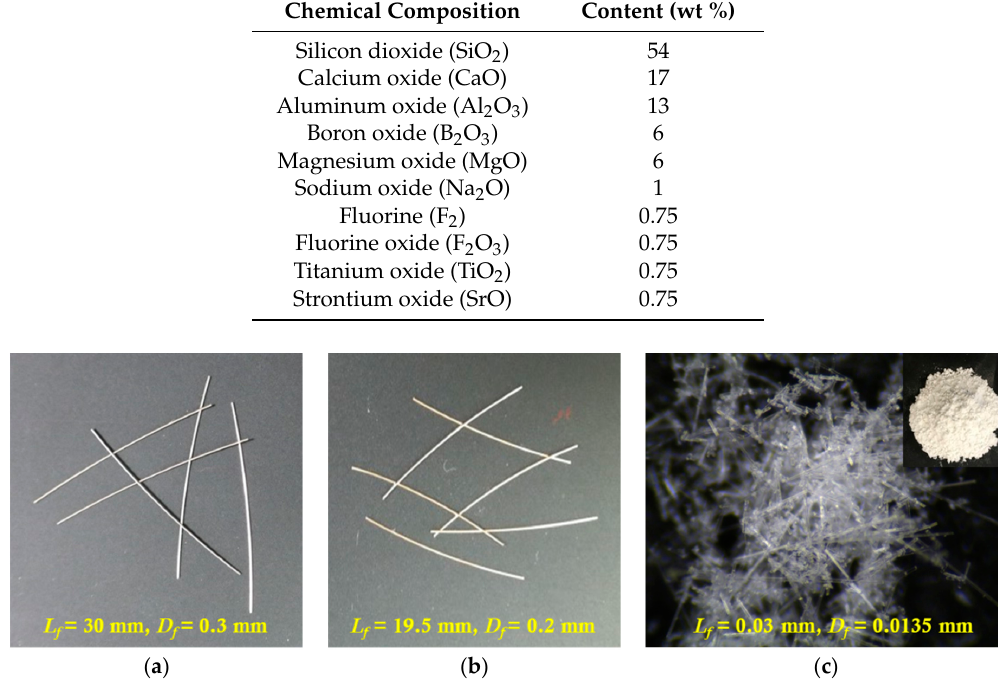
Figure 4. Geometries of the fibers: ( a ) long smooth-, ( b ) medium smooth-steel fibers, and ( c )